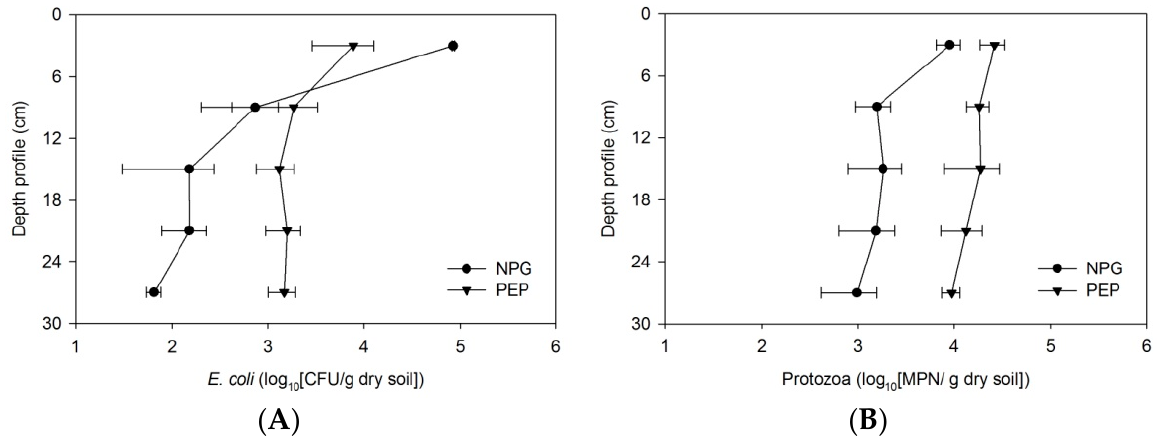
Figure 5. Distribution of prey and predators in PEP and NPG soil columns concerning filter depth. ( A ) Absorbed E. coli in the soil media. ( B ) Protozoa abundance.